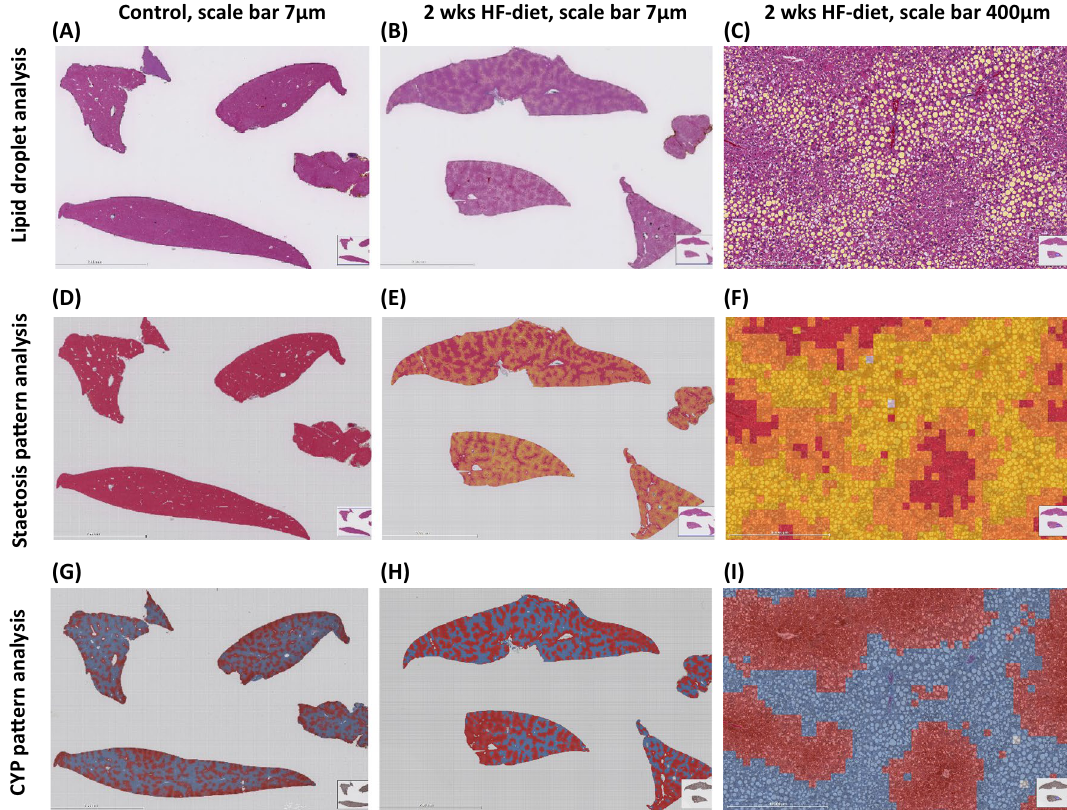
Figure 9. Image analysis of whole slide scan with sections from four different liver lobes using Histokat event recognition and pattern recognition algorithm; ( A ) Overlay image of normal liver after color coding of lipid droplets with yellow; ( B , C ) Overlay image of steatotic liver after color coding of lipid droplets with yellow; ( D ) Overlay image of normal liver after color coding the different patterns to be quantified; ( E , F ) Overlay image of steatotic liver after color coding the different patterns to be quantified. Square tiles classified into three color classes (orange for microvesicular steatosis, yellow for macrovesicular steatosis and red for non- steatotic hepatocytes, lumen of the vessels excluded); ( G ) Overlay images of normal liver after color coding the immunohistochemical visualization of CYP3A4 expression; ( H , I ) Overlay images of steatotic liver after color coding the immunohistochemical visualization of CYP3A4 expression. Square tiles classified into two color classes (blue for the CYP negative or mildly stained hepatocytesand red for strong to moderate CYP stained hepatocytes). Antibody Company